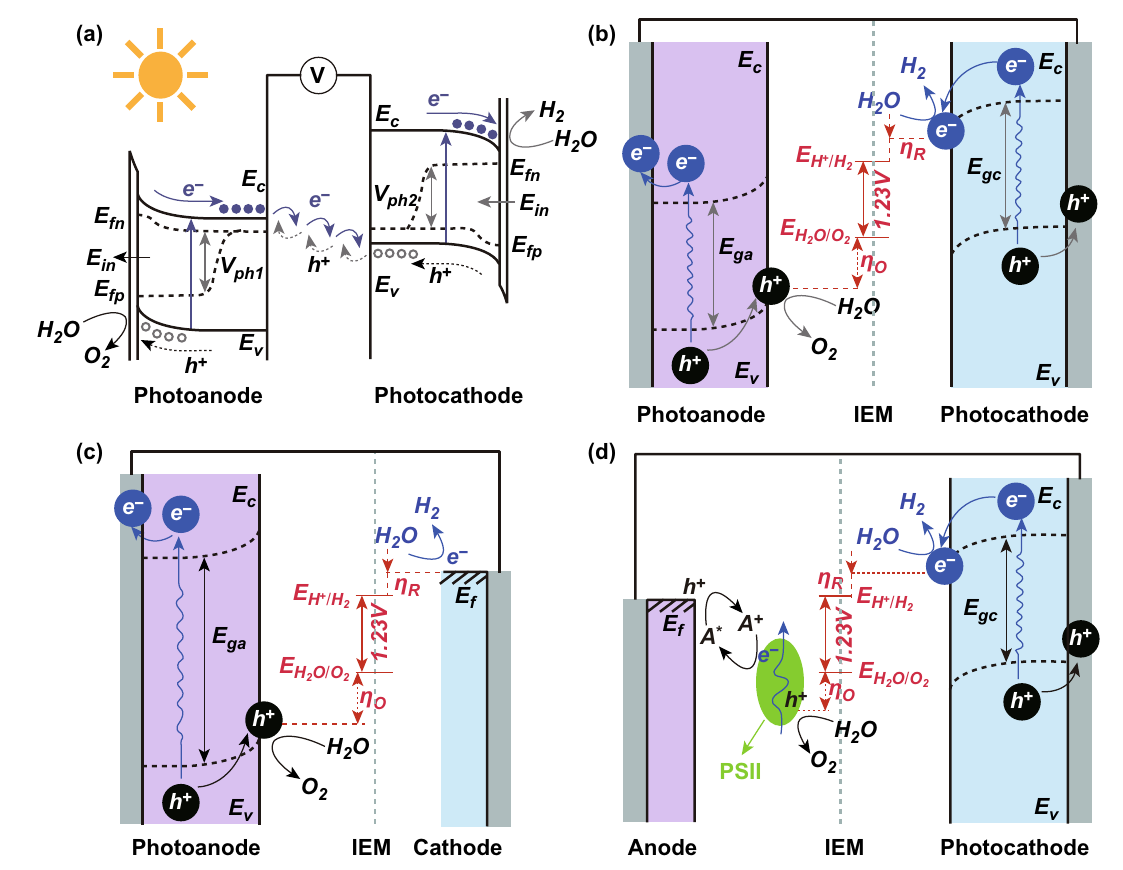
Fig. 2 a Scheme of energy diagram in a typical PEC system. Ein: built-in electric field in depletion region, Ef: Fermi level, Ec: conduction band, Ev: valence band, Efn: quasi-Fermi level of holes, Efp: quasi-Fermi level of electrons. PEC systems with different models of b photoanode and photocathode, c photoanode alone, and d photoanode along with PSII and A +/A*redox couple. Reproduced with permission from Ref. [47]. Copyright 2015